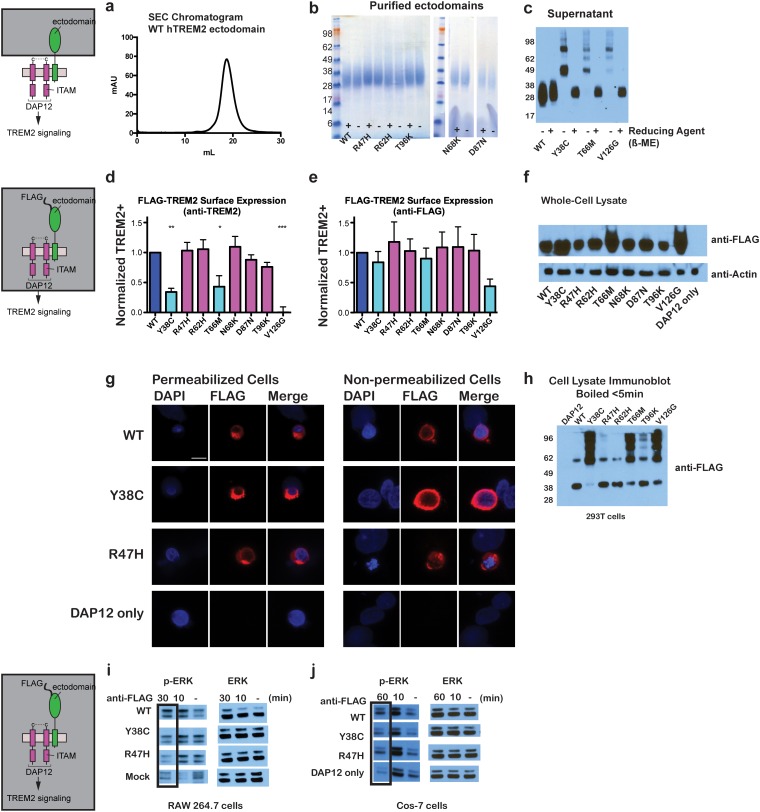
Chromatographic and surface expression analysis of WT and variant TREM2.The schematic depicts the domain of TREM2 used in the experiments shown in (a–c). (a) Gel filtration chromatography profile (Superdex 200 10/300 GL) of purified WT human TREM2 ectodomain showing a single monomeric peak. (b) SDS-PAGE analysis of purified TREM2 AD risk variants prepared with (+) and without (-) reducing agent (β-mercaptoethanol). (c) Western blot analysis of TREM2 NHD mutants secreted from transfected 293F cells prepared with (+) and without (-) reducing agent (β-mercaptoethanol). The NHD mutants Y38C, T66M, and V126G all migrate as higher MW oligomers under non-reduced conditions, indicating that they are misfolded and linked by aberrant intermolecular disulfide bonds. Purified WT TREM2 is shown for comparison. Representative of more than three independent expressions. The second schematic depicts FLAG TREM2 used in the experiments shown in (d–h). (d–e) Surface expression of WT and variant TREM2 in 293F cells assayed by flow cytometry. Full-length FLAG-WT or mutant TREM2 were co-transfected with mDAP12 into 293F cells. Surface expression was measured by either (d) a polyclonal serum or (e) an anti-FLAG antibody. Normalized TREM2 indicates the normalized fraction of cells staining positive over DAP12-only background. Data are from four (d) or five (e) independent experiments. Bars are color-coded in the same way as the residues in Figure 1b (cyan = NHD mutant; magenta = AD risk variant). Error bars are SEM. Significance was determined by ANOVA with Bonferroni post-test correction. (*p<0.05, **p<0.01, and ***p<0.001). (f) Western blot analysis of whole-cell lysates of 293F cells used in (d) and (e) showing expression levels of WT, NHD mutant (Y38C, T66M and V126G), and AD risk variant (R47H, R62H, N68K, D87N and T96K) TREM2. Note that the NHD mutants are more highly expressed than the AD risk variants. (g) Confocal microscopy of 293F cells co-transfected with DAP12 and FLAG-TREM2. Cells were fixed and either permeabilized (left) or non-permeabilized (right) and stained with anti-FLAG antibody (red). (h) FLAG-TREM2 full-length constructs were co-transfected with DAP12 into 293T cells and expression analyzed by anti-FLAG immunoblot. Samples were prepared by suspending cells in reducing SDS loading buffer and boiling for no more than 5 min. We observe SDS-resistant aggregate bands for the NHD variants, which were largely absent in WT and AD risk variants. The T96K variant shows some light aggregation, consistent with the slight shift (~5°C) in denaturation temperature for that variant (Figure 3). Schematic depicts FLAG TREM2 signaling assay employed in the experiments shown in (i–j). (i) TREM2 signaling analyzed by phosphor-ERK1/2 and ERK1/2 immunoblot in RAW264.7 macrophage cells transfected with WT or variant FLAG-TREM2. (RAW264.7 cells express endogenous DAP12.) 24 hr post-transfection, cells were stimulated with anti-FLAG antibody (1:100) for the indicated length of time. ERK/pERK content was assessed by immunoblot. In these cells, we observe pERK at 10 min post-stimulation. However, only WT sustained signaling 30 min post-stimulation. (j) TREM2 signaling analyzed in Cos-7 cells as in (c). Cos-7 cells were co-transfected with DAP12 and TREM2. In these cells, there is a non-specific antibody response at 10 min. However, as in the RAW264.7 cells, we observe sustained WT signaling at the later time point which is diminished in R47H and Y38C variants.